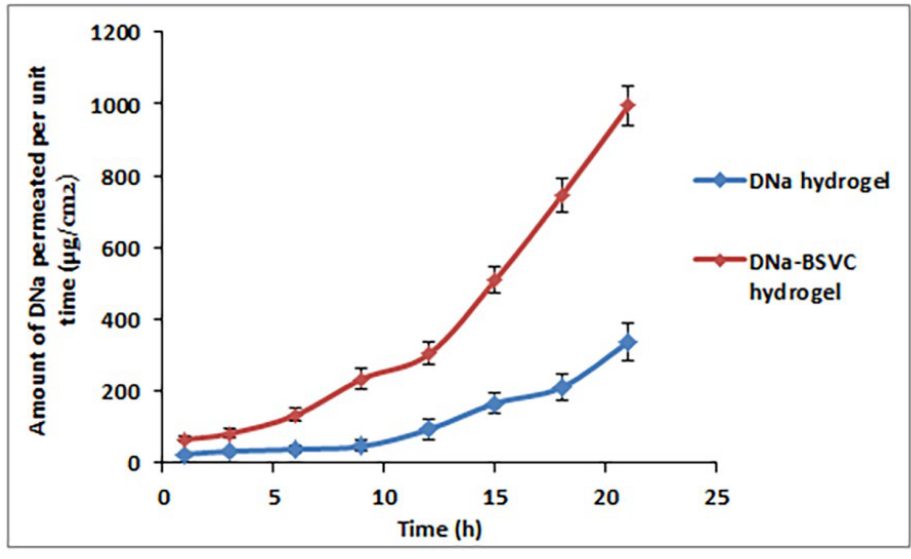
Figure 8. Ex vivo skin permeation of DNa hydrogel and DNa-BSVC hydrogel.